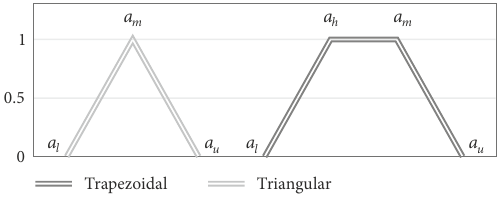
Figure 1. Schematic view of triangular and